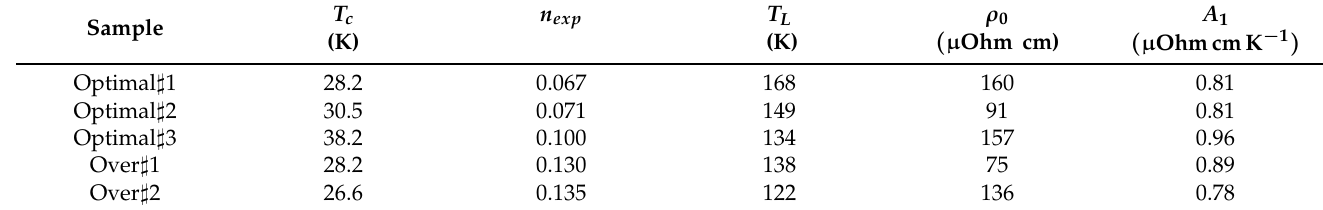
Table 3. The superconducting transition T c temperatures, the expected electronic doping n exp esti- mated from the superconducting critical temperatures T c [53] and the T L defined as the temperature at which resistivity curves are no longer linear. The best fit parameters A 1 and σ 0 are also reported.